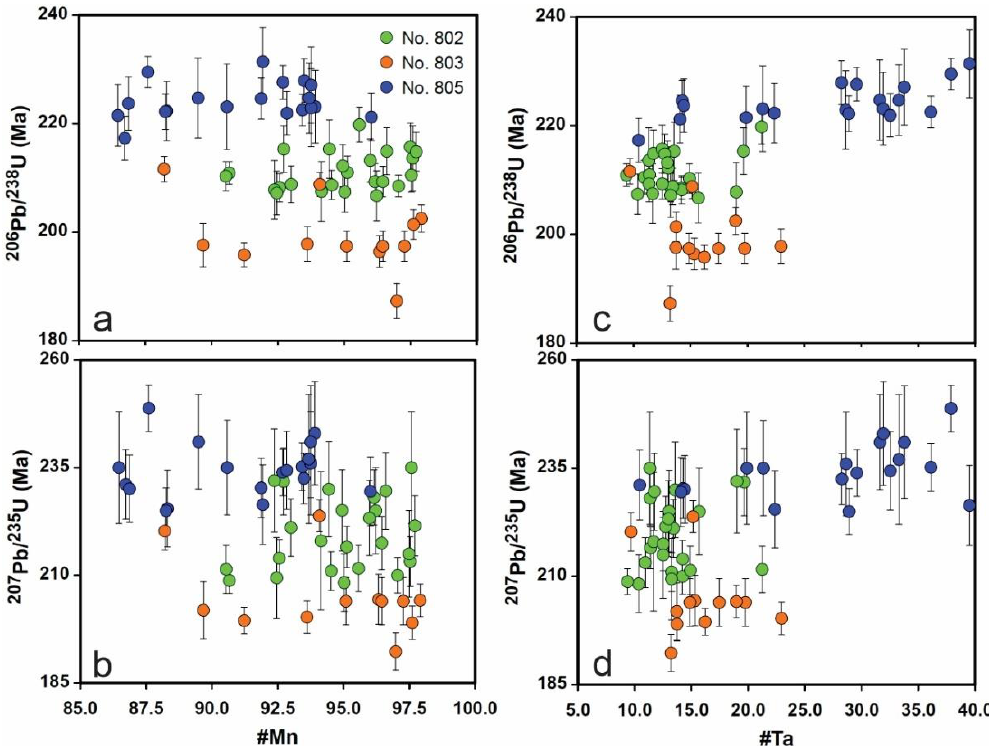
Figure 11. Binary plots showing correlations between columbite LA-ICP-MS U-Pb ages and #Mn and #Ta values of CGMs from the Kalu’an lithium pegmatites, ( a ) and ( b ) variations in 206 Pb / 238 U and 207 Pb / 235 U ages versus #Mn, ( c ) and ( d ) variations in 206 Pb / 238 U and 207 Pb / 235 U ages versus #Ta. The #Mn and #Ta values for the analytical spots on CGMs during LA-ICP-MS dating are based on the EPMA data for the same spots. The error bars represent the analytical errors (2 σ ) for 206 Pb / 238 U and 207 Pb / 235 U ages. The dataset including U-Pb ages and the #Mn and #Ta values is provided in Supplementary Material Table S4.